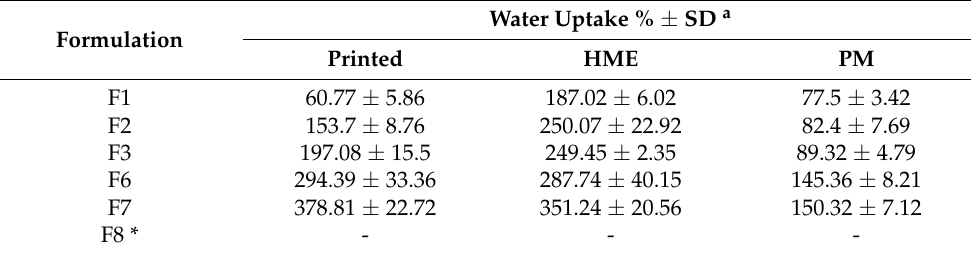
Table 10. Water uptake of tablets made by various techniques.